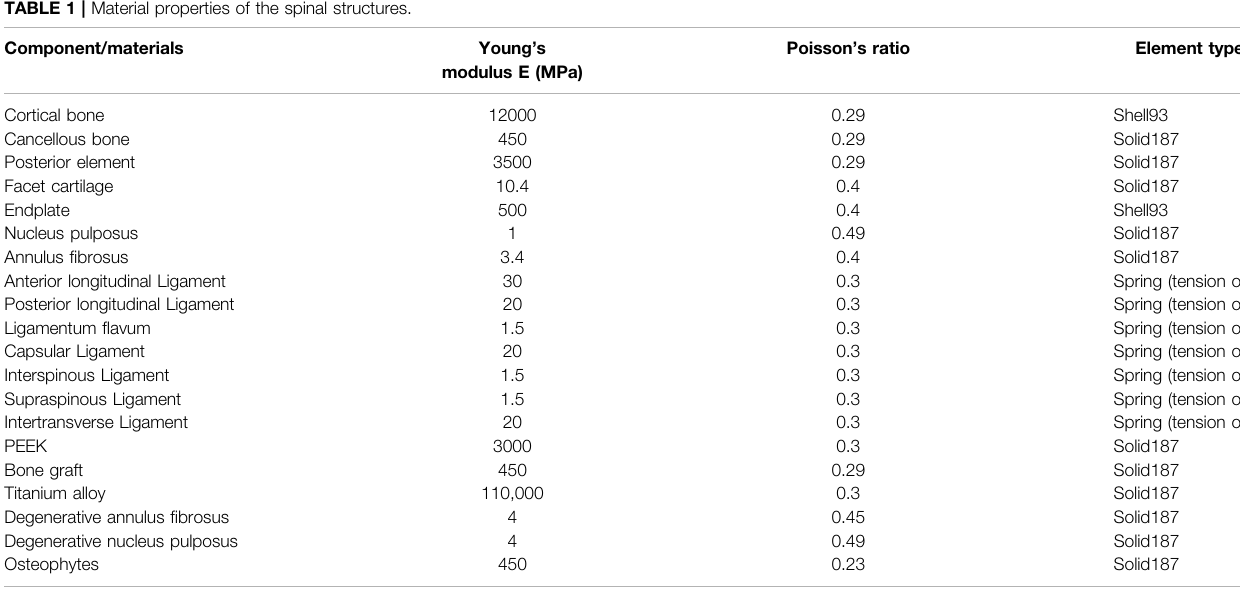
TABLE 1 | Material properties of the spinal